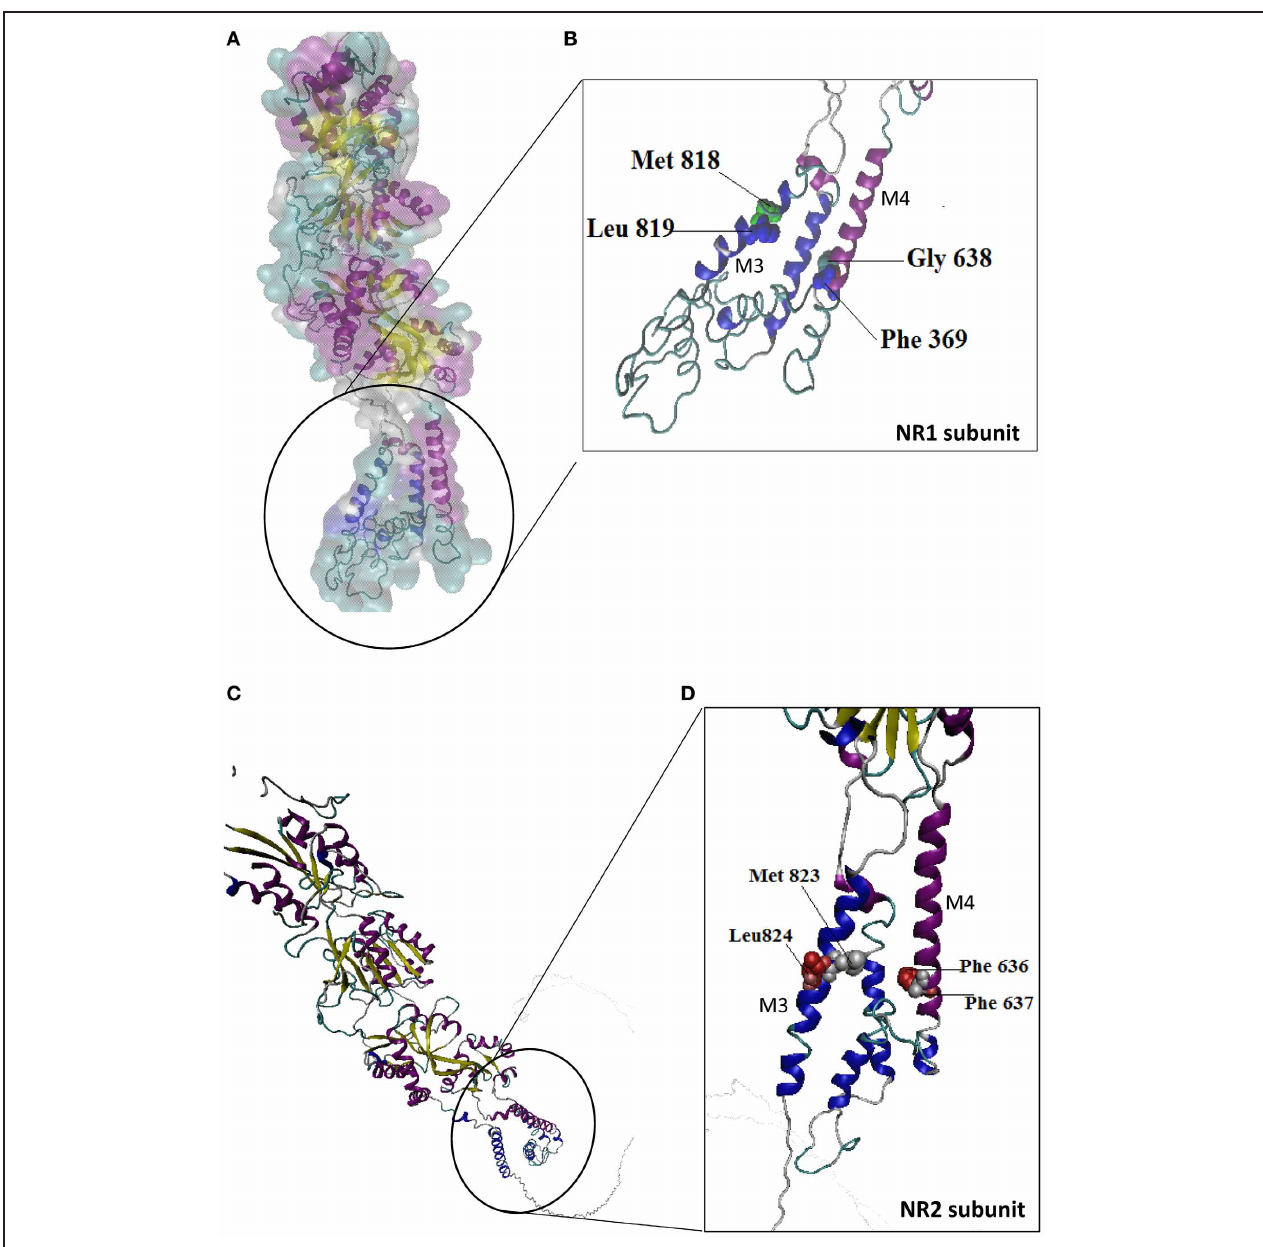
FIGURE 6 | Molecular structure of the NR1/NR2 subunit pairs shows a continuous molecular view. A model of the mouse NR1/NR2 subunit was derived by homology modeling and is depicted as a stereo view transparent grid surface ribbon model (A,C) . Position in NR1 subunit was highlighted green (Met818, Leu819) and blue (Gly638, Phe639) residue are possible binding region of M3 and M4 domain. (B) Position in NR2 subunit M3, M4